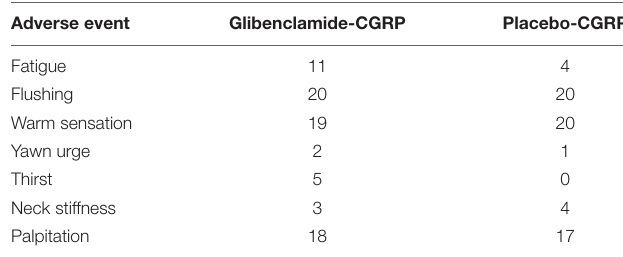
TABLE 2 | Incidence of adverse events 0–14 h after glibenclamide or